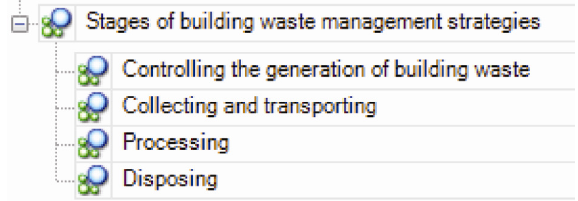
Fig. 2. Coding structure used for data